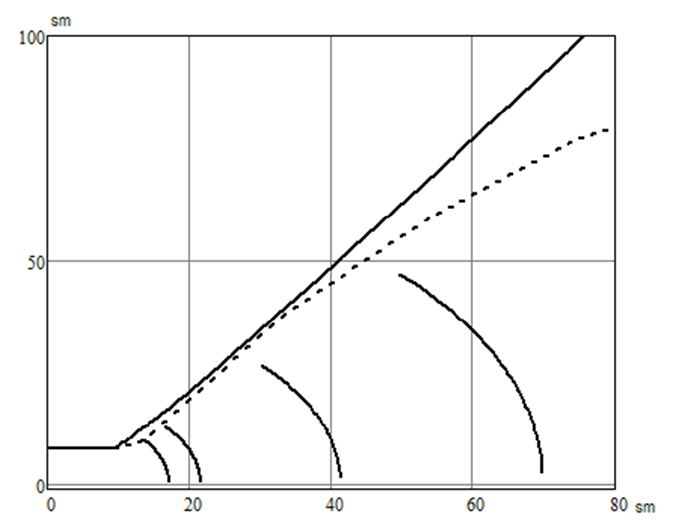
Figure 7. Plots of extreme current line and some equipotentials (solid) obtained from numerical calculations and extreme current line obtained from in situ experiments